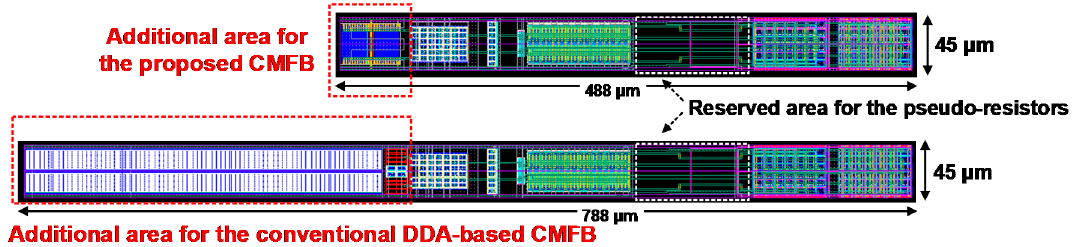
Figure 9. Layouts of an FC-OTAs with the proposed CMFB ( top ) and DDA-based CMFB ( bottom ).